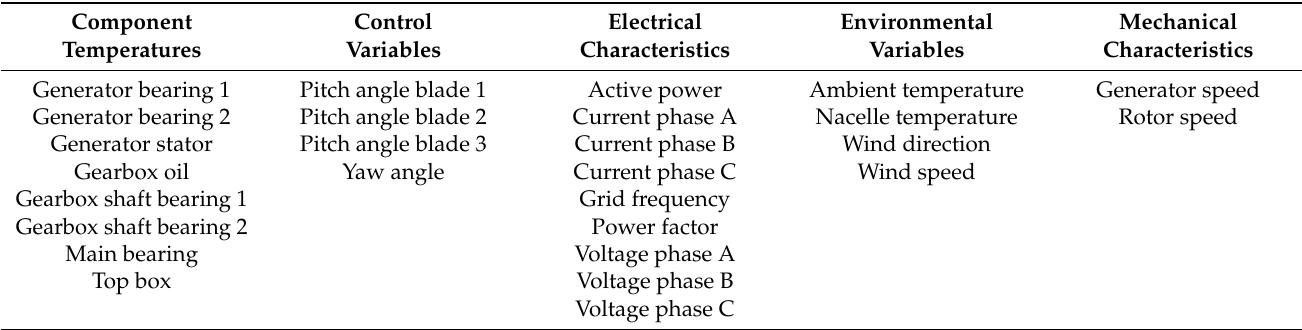
Table 1. List of SCADA signals analyzed in this